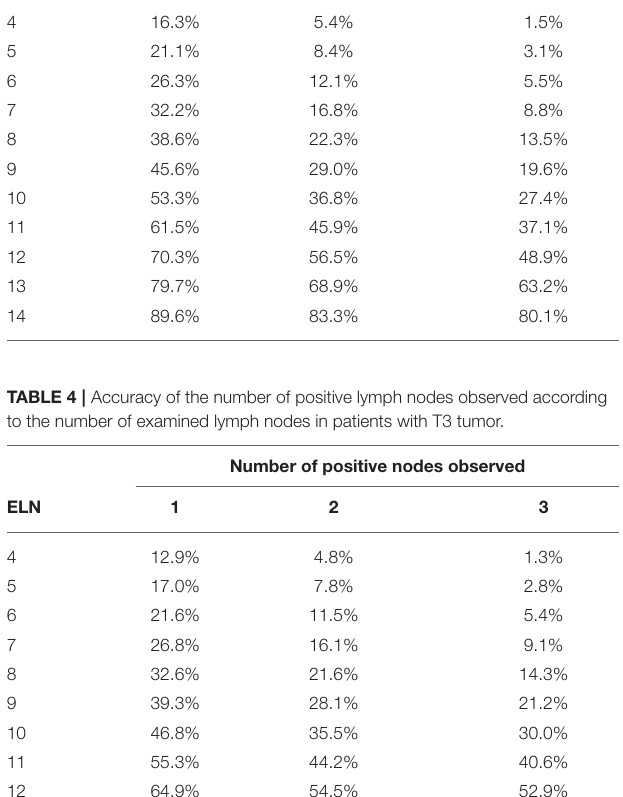
Table 2 . For example, 14 lymph nodes were examined in a patient with T1 tumor, and the accuracy of observation of 1 positive lymph node was 91.1%; 2 positive nodes, 84.8%; and 3 positive nodes, 82.0%.